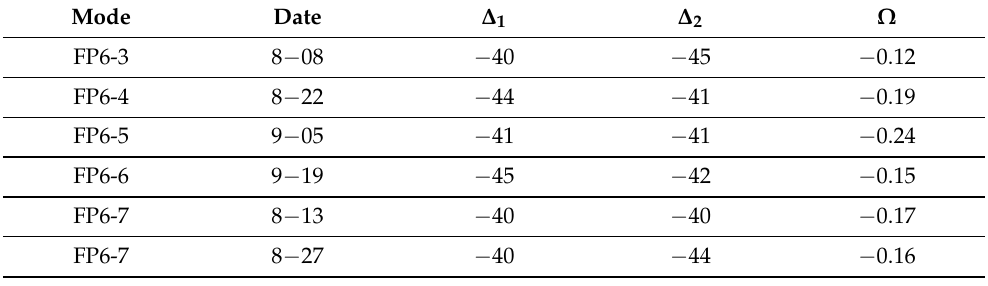
Table 2. PALSAR2 Antenna Cross-Talks (in dB) and Faraday Rotation (in degree).